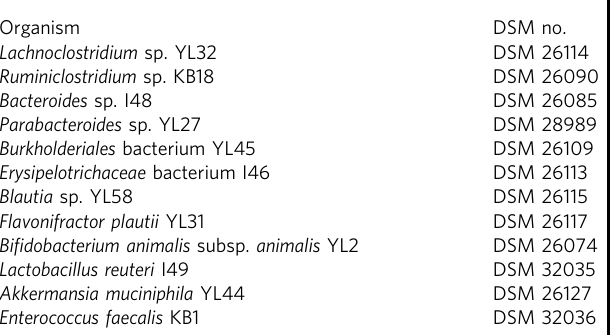
Table 1 Microbial organisms used for sDMDMm2 mice.